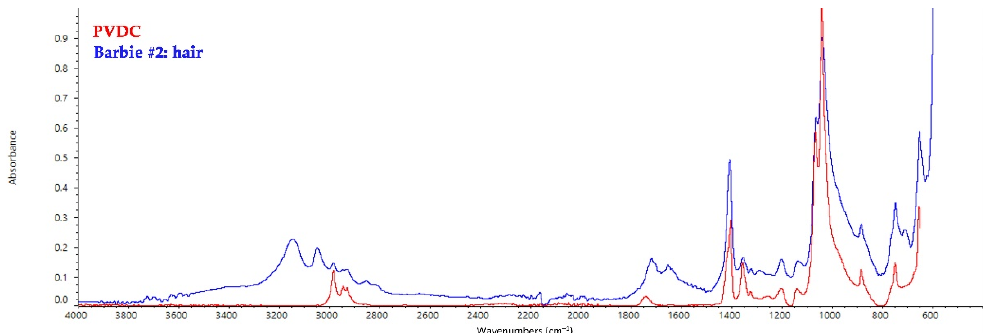
Figure 2. FT-IR ATR spectrum collected on the hair of Barbie #2 and shown as a model spectrum of PVDC hair in all the other dolls, with the reference spectrum of PVDC.